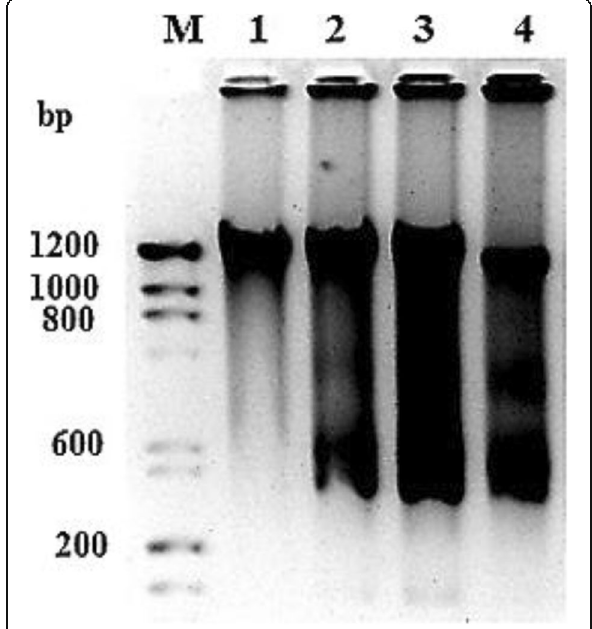
Fig. 9 DNA fragmentation of HepG2 cells induced upon treatment with fungal EDT. M DNA molecular size marker, 1 DNA from untreated control cells, 2 – 4 show DNA from fungal EDT treated